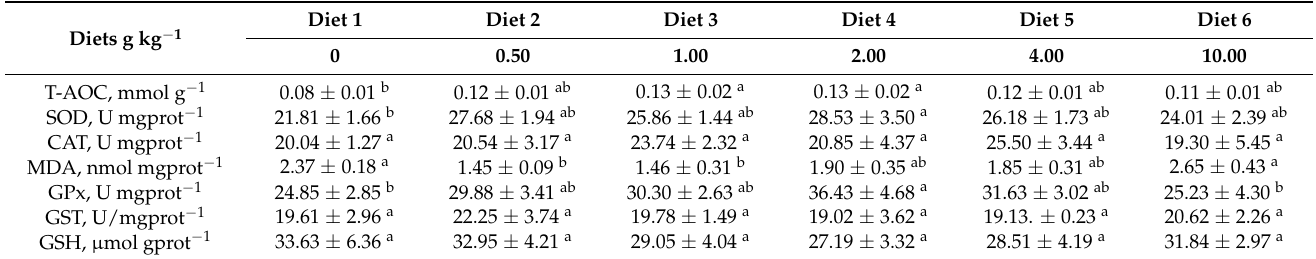
Table 7. Effects of ELE on antioxidant abilities of the hepatopancreas in Cherax quadricarinatus .